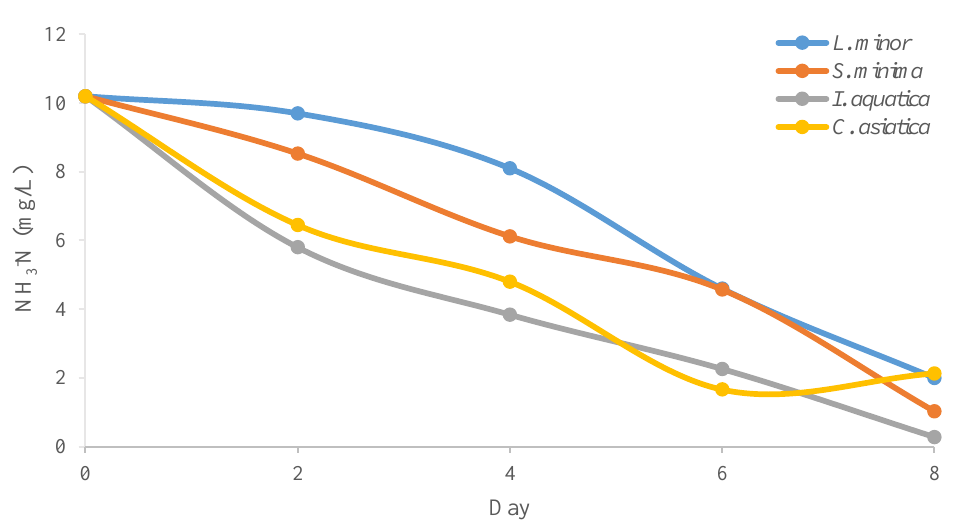
Figure 4. The average of NH 3 -N reading by the phytoremediation using Lemna minor , Salvinia minima , Ipomoea aquatica and Centella asiatica .